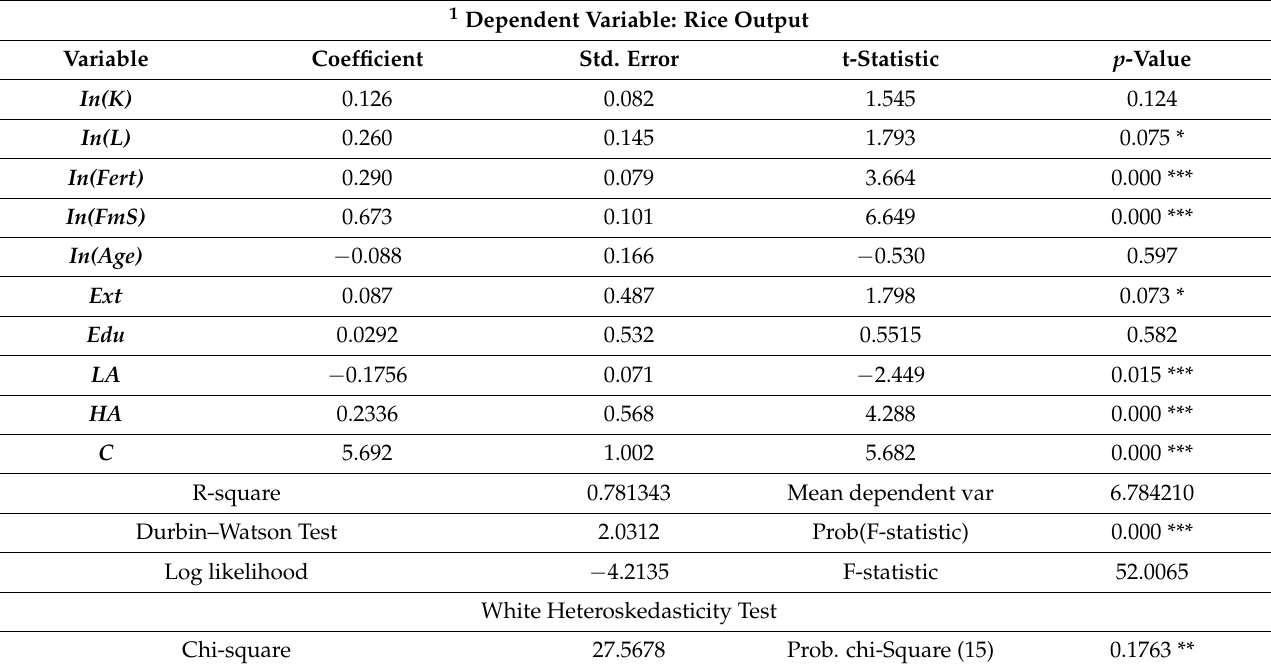
Table 7. Results of OLS